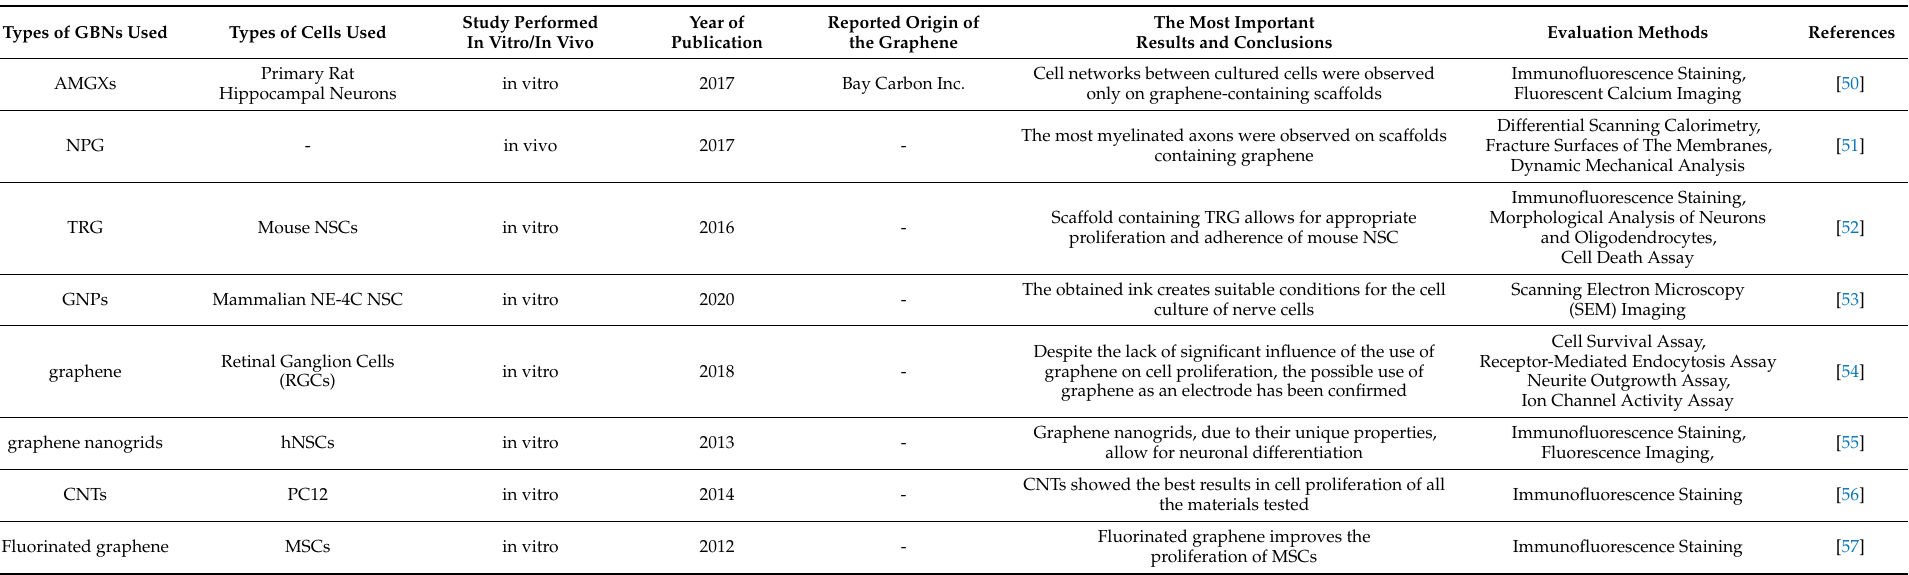
Table 6. List of relevant studies conducted with utilization of other